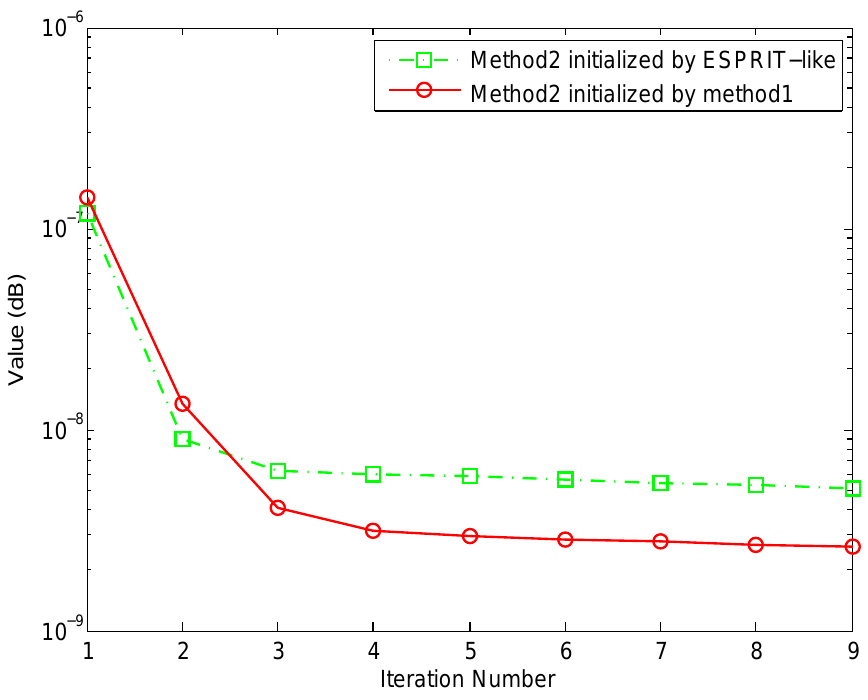
Figure 1. Value of the stopping criterion versus iteration number with different initial values. The number of snapshots N = 500 , and SNR = 15